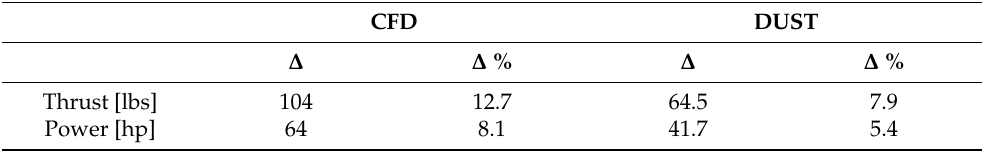
Table 5. Comparison of the average proprotor global thrust and power variations due to the wing installation, α = 5 ◦ , V ∞ = 220 kts, Ω = 517